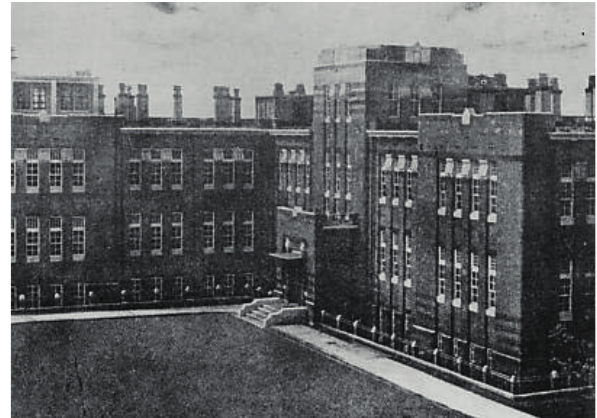
Figure 7. RIKEN building in Komagome, in northern Tokyo. (Reproduced with permission from